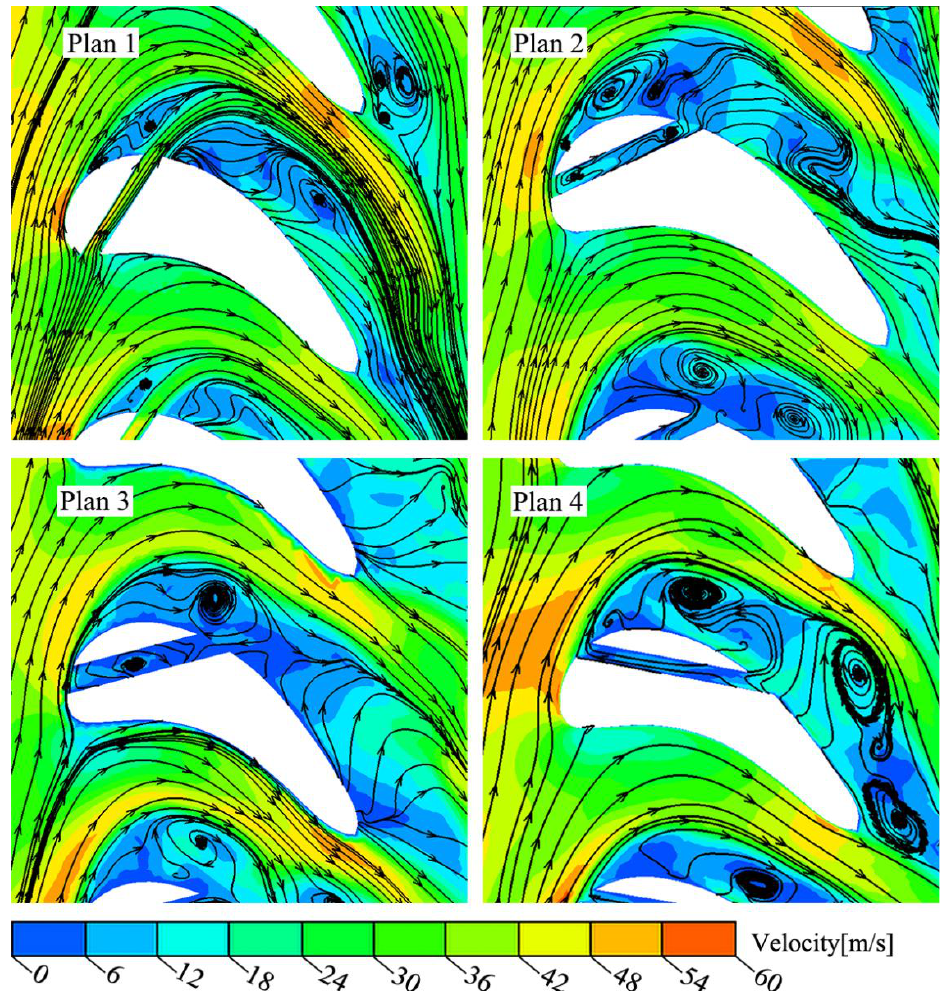
Figure 11. Velocity distribution in stator domain under stall operating condition for various suppression slots ( t = 0.12 s).